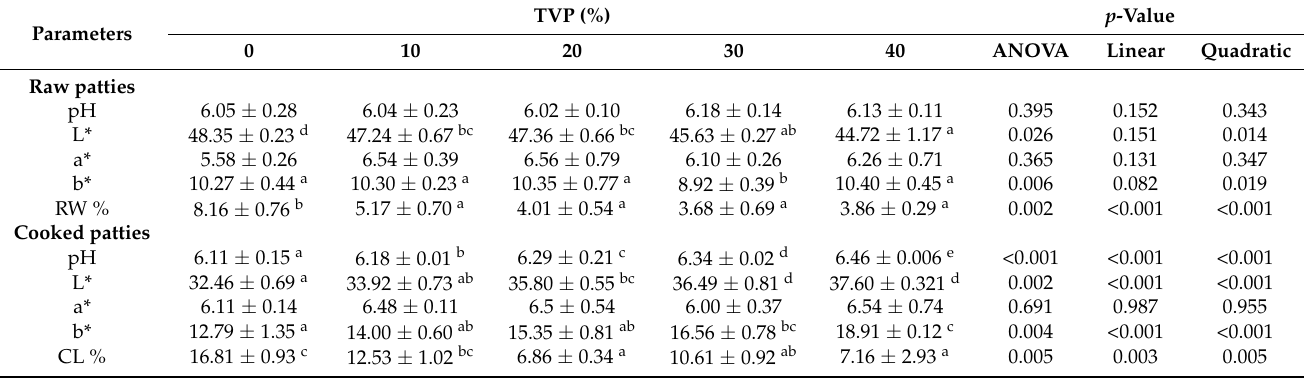
Table 3. Physiochemical characteristics of the beef patties replaced with different levels of